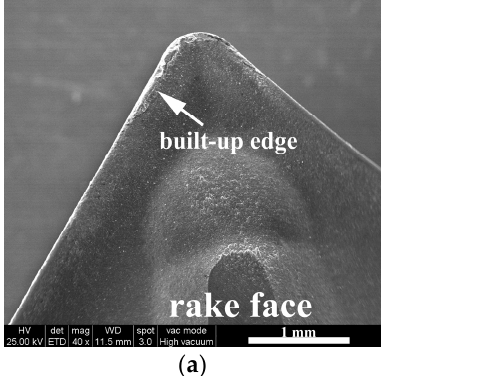
Figure 15. SEM images of the TiAlN-coated insert at feed rate of 0.2 mm/r after machining for 12 min (cutting speed of 50 m/min, depth of cut of 1.0 mm): ( a ) rake face; and ( b ) flank face.